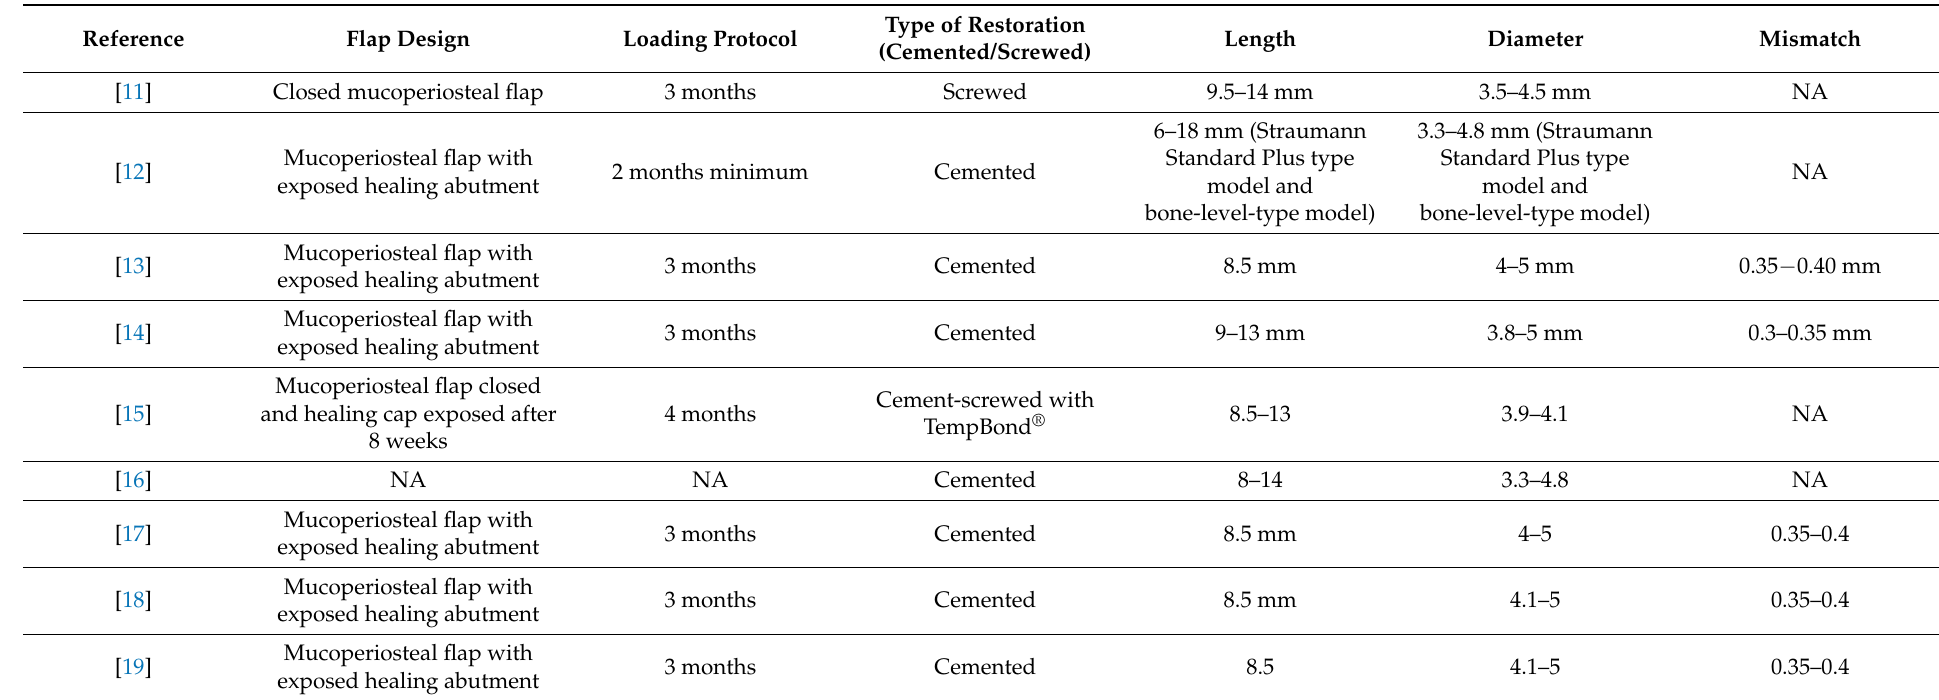
Table 2. Implant